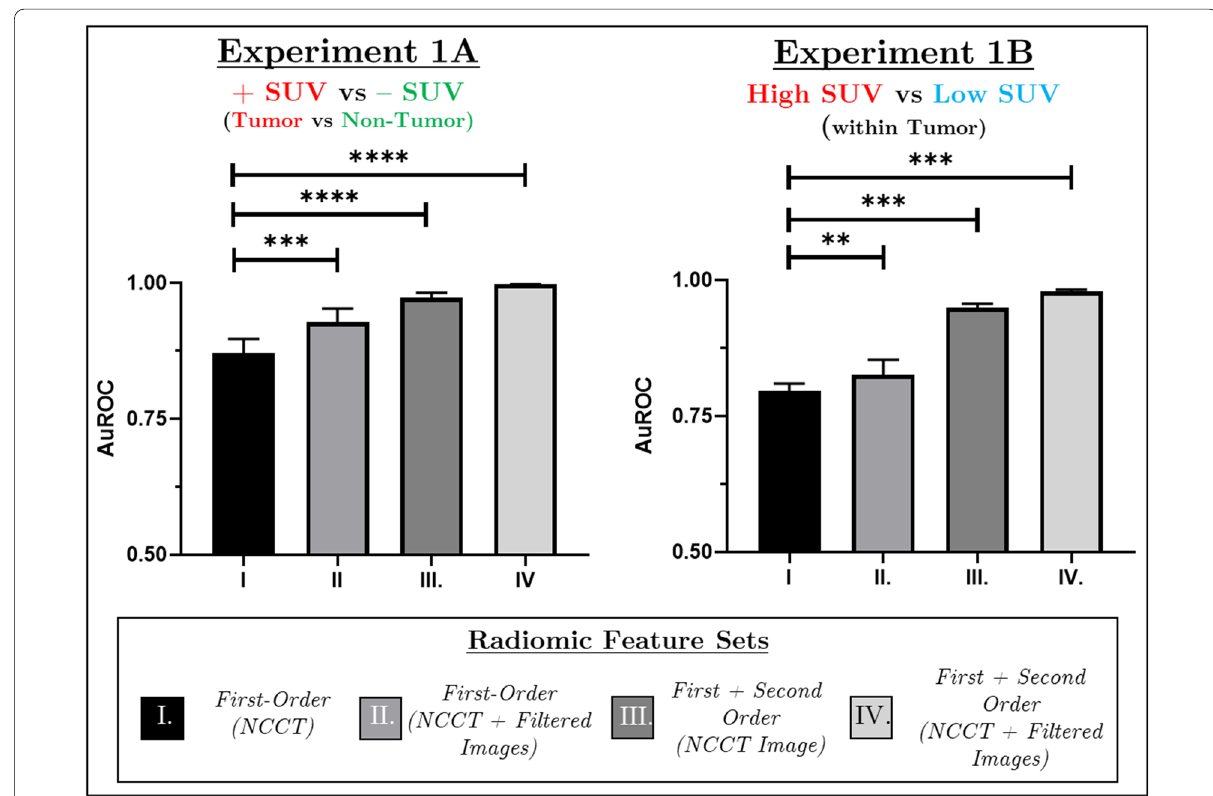
Fig. 2 Area under receiver operation curves for four random forest models trained with a combination of radiomic features to classify CT regions based on FDG uptake. Experiment 1A compared regions of elevated versus negligible FDG uptake. Experiment 1B compared tumour regions of High versus Low FDG uptake. Each model was trained using a tenfold cross-validation method for 100 iterations on a selected group of 25 radiomic features. Following training, each of the 100 models is applied to the testing cohort to assess model performance. The statistical differences between each model are assessed using a one-way ANOVA. ** p < 0.01; *** p < 0.001; **** p <